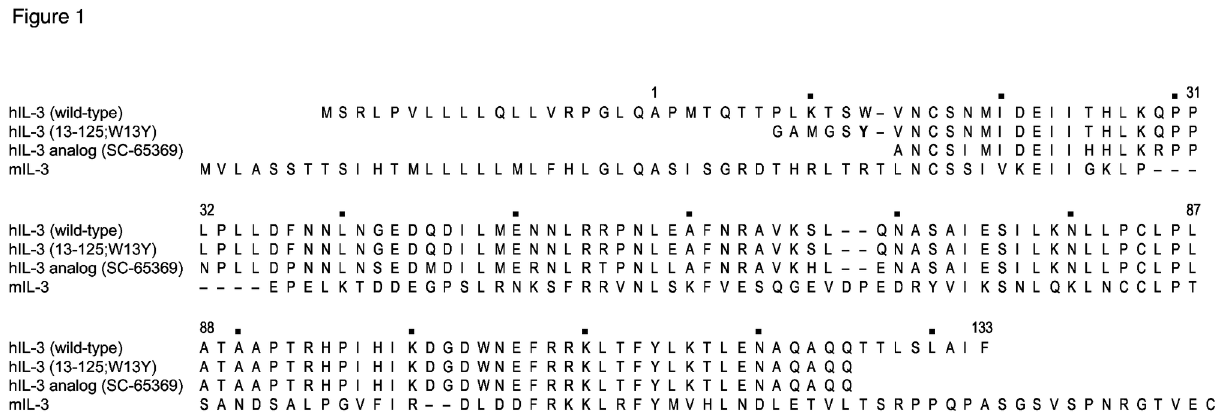
Figure 1. Alignment of amino acid sequences of human and mouse IL-3. The amino acid sequences of full length wild-type hIL-3, hIL-3(13-125; W13Y), the hIL-3 analog SC-65369 [41], and wild-type full length mouse IL-3 were manually aligned owing to low homology between mouse and human IL-3 (29% identity). Numbers above the sequence refer to the mature form of full length hIL-3 with dots above every 10 th residue. The sequences shown in gray for full length hIL-3 and full length mouse IL-3 are signal peptides that are cleaved during secretion. The key substitution, W13Y in hIL-3(13-125; W13Y), is shown in bold text and